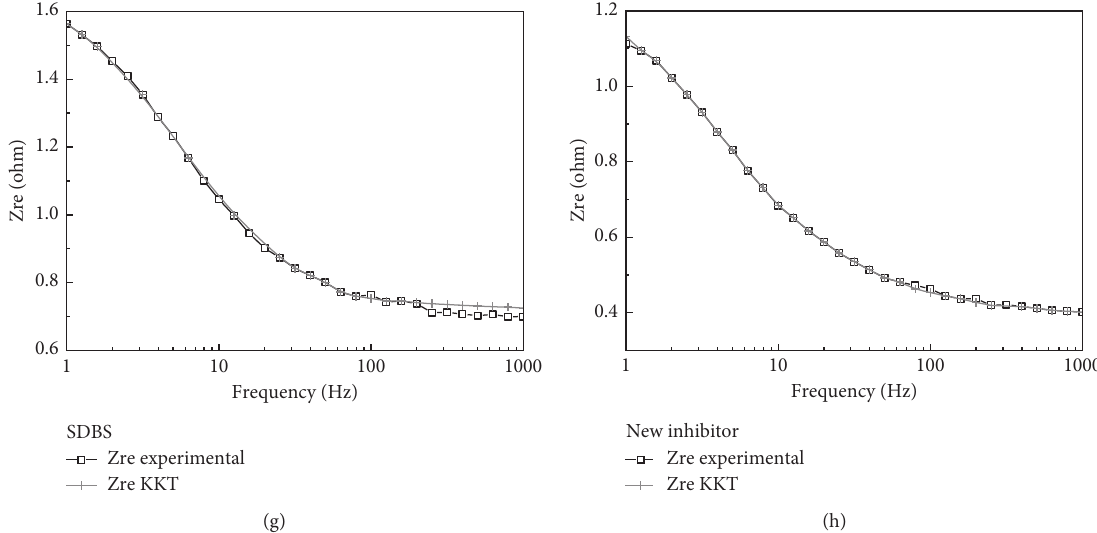
Figure 11: Comparison of experimental and KKT values of Zreal. Creak initiation: (a) without inhibitor. (b) Sodium succinatec. (c) SDBS. (d) New corrosion inhibitor. Creak propagation: (e) without inhibitor. (f) Sodium succinate. (g) SDBS. (h) New corrosion inhibitor.